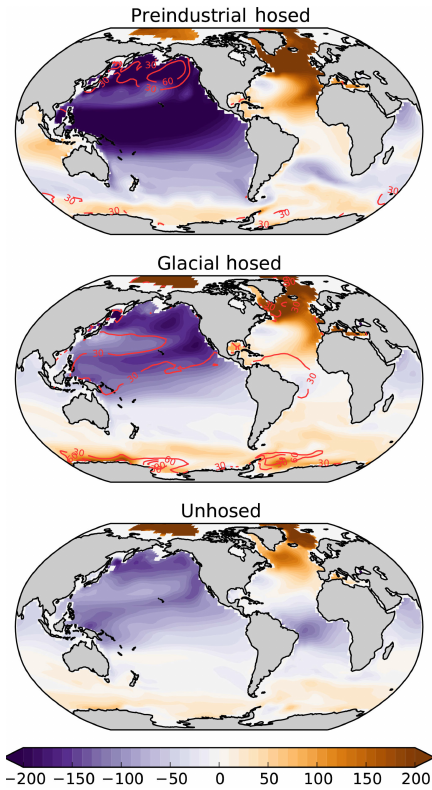
Figure 10. Stadial intermediate-depth (400–1100m) ideal age anomaly. The top two panels show the age difference between weak and strong AMOC states (as defined in Fig. 3) under preindustrial and glacial boundary conditions, averaged between the four sets of orbital configurations (see Fig. S9 to view all eight hosing simu- lations individually). Red contours show the standard deviation be- tween the four sets of orbital configurations at 30-year intervals. The bottom panel shows the age difference between weak and strong AMOC states (as defined in Fig. 3) in the unhosed simulation. Shad- ing and contours in